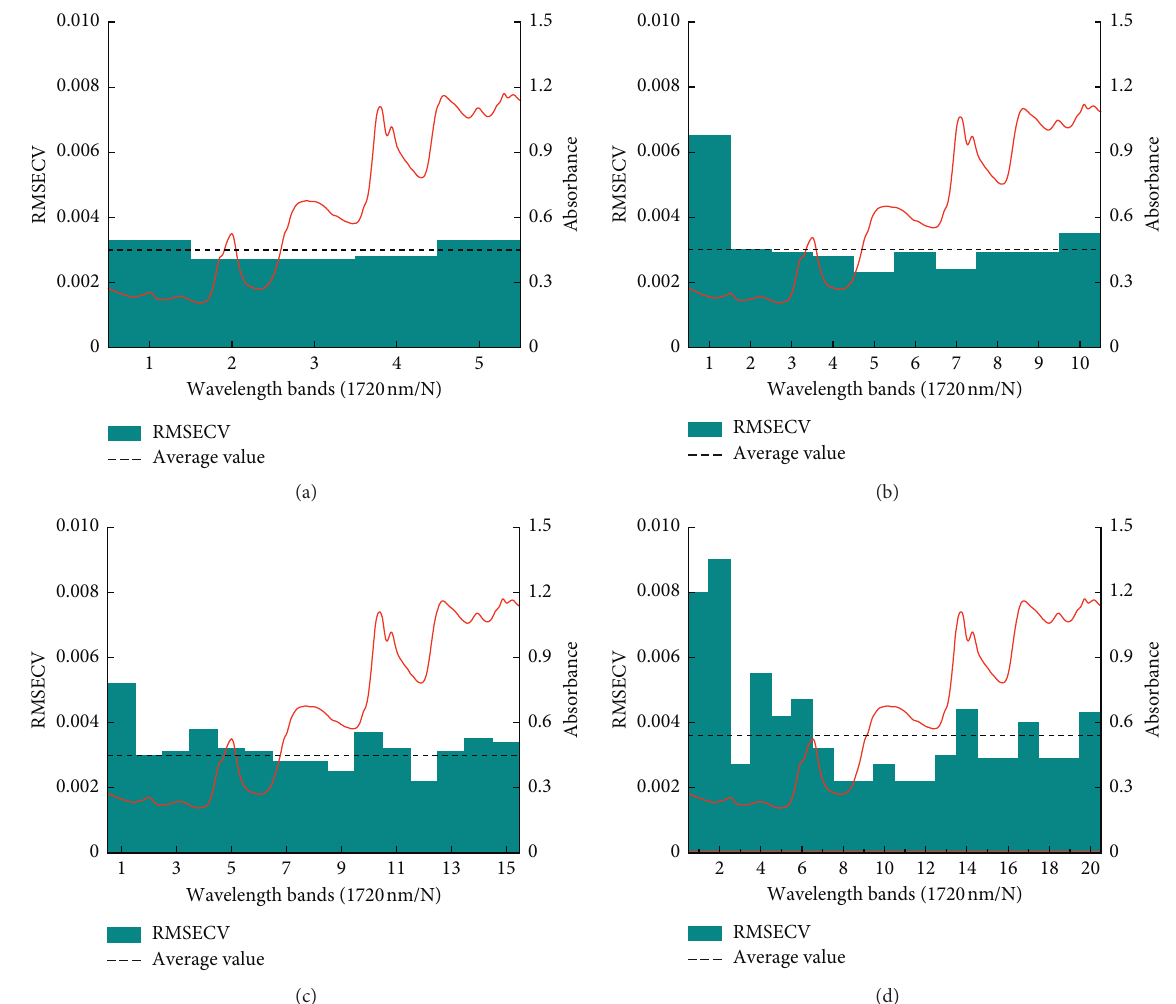
Figure 3: Prediction results of walnut kernel moisture content in different spectral bands.